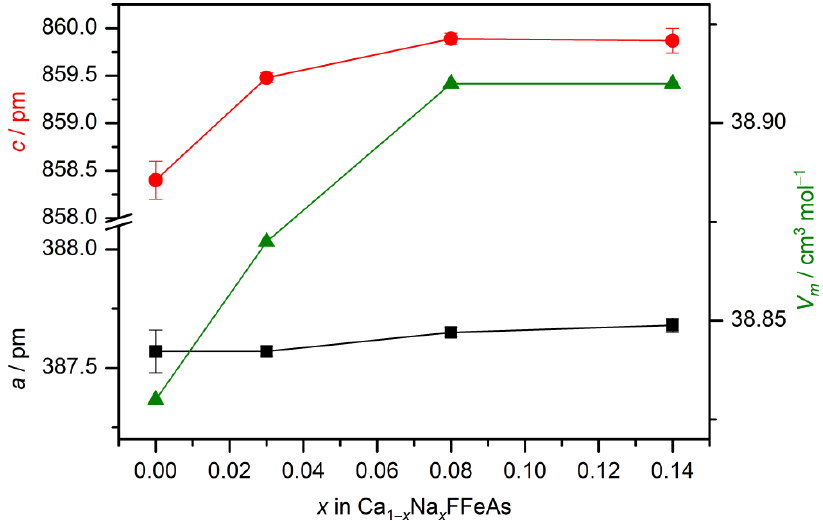
Figure 5. Lattice parameters and molar volumes of Ca sodium doping grade x (from energy dispersive X-ray spectroscopy